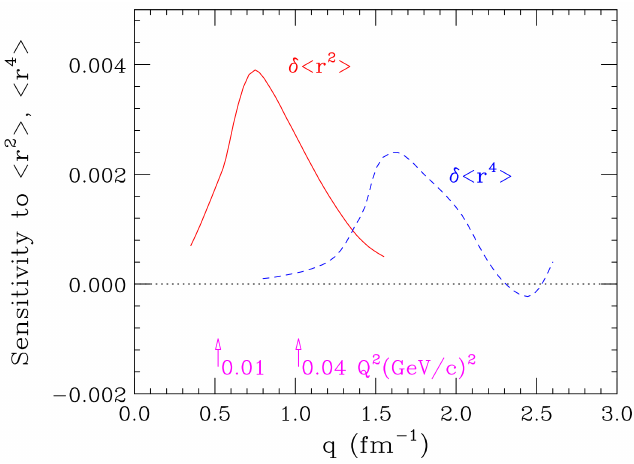
Figure 4. Sensitivity of the charge rms-radius and the 4’th moment to the e-pdata at varying q n